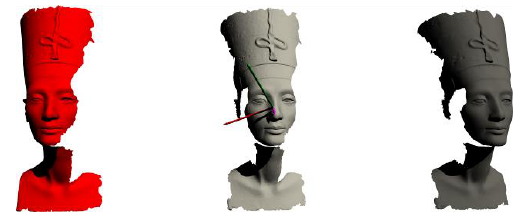
Figure 6. Datasets acquired from viewpoint 2 (red) and viewpoint 1 (dark grey). The overlapping region of these two meshes, as depicted in the centre, is coloured in light grey.